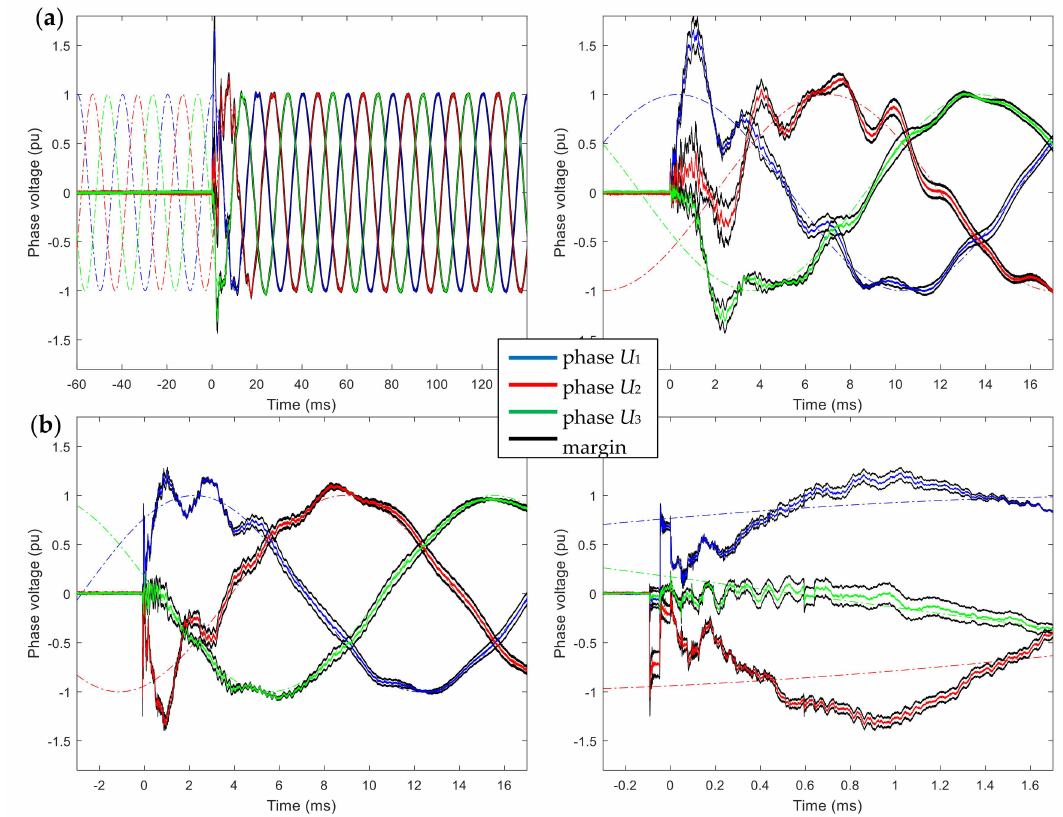
Figure 4. Reconstructed waveforms for substation measurements recorded with 5 Msample / s over a duration corresponding to ten power cycles. The curves in colour represent the three phases with confidence margins in black: ( a ) Full and 10 times zoomed waveform showing overvoltages during the first cycle from energization at the far end of the connection; ( b ) Waveform with overvoltages during the first power cycle from energization at the near end and 10 times zoomed waveform revealing initial travelling waves along the connection. The extrapolated power cycles (dash-dotted lines) indicate the 50 Hz phase angles at the moments of